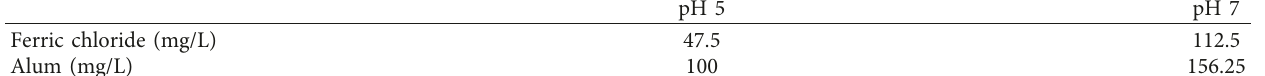
Table 2: Effect of pH on the critical coagulation concentration of laterite suspension